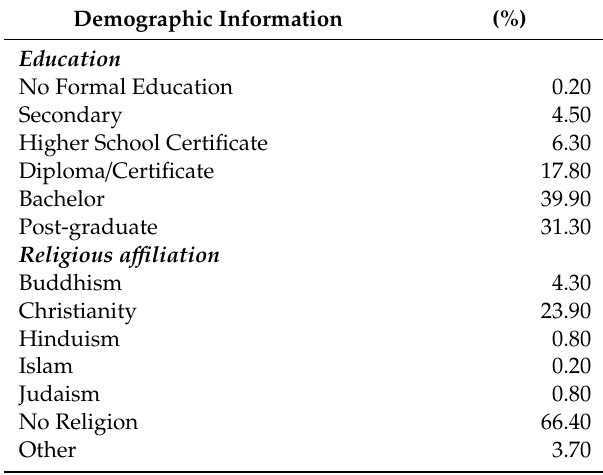
Table 1. Demographic information for the study sample ( n =